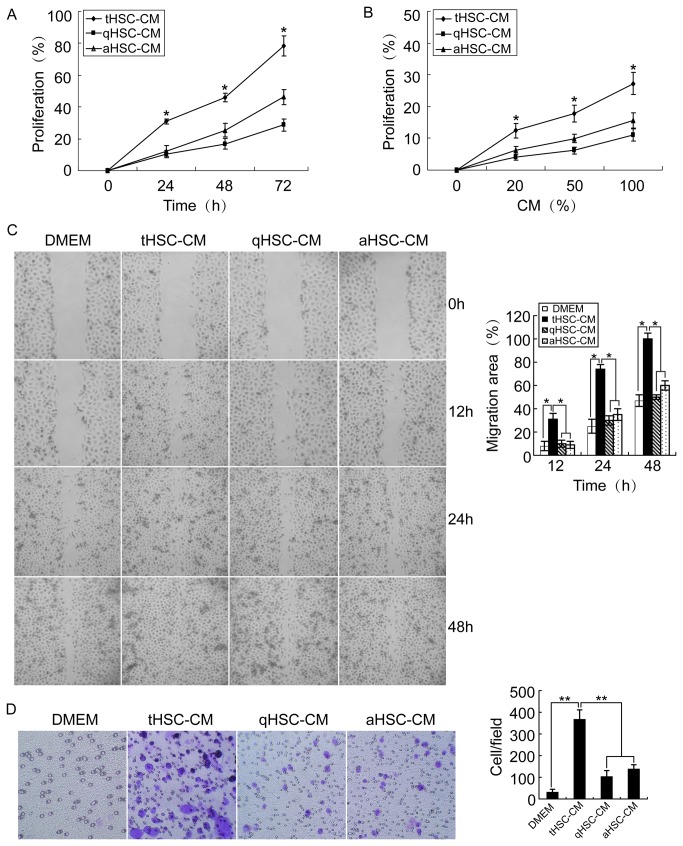
tHSC-CM promoted proliferation, migration and invasion of PLC/PRF/5 cells.(A and B) tHSC-CM significantly promoted HCC cell growth with time- and concentration-dependent manner. (C) Representative images of wound migration assays (left panel). Results are expressed as the percentage of the wounded area (right panel). (D) Representative images of invasion assays performed by transwell chamber (left panel). Results are expressed as the number of cells per field (right panel). *p < 0.05; **p < 0.01.